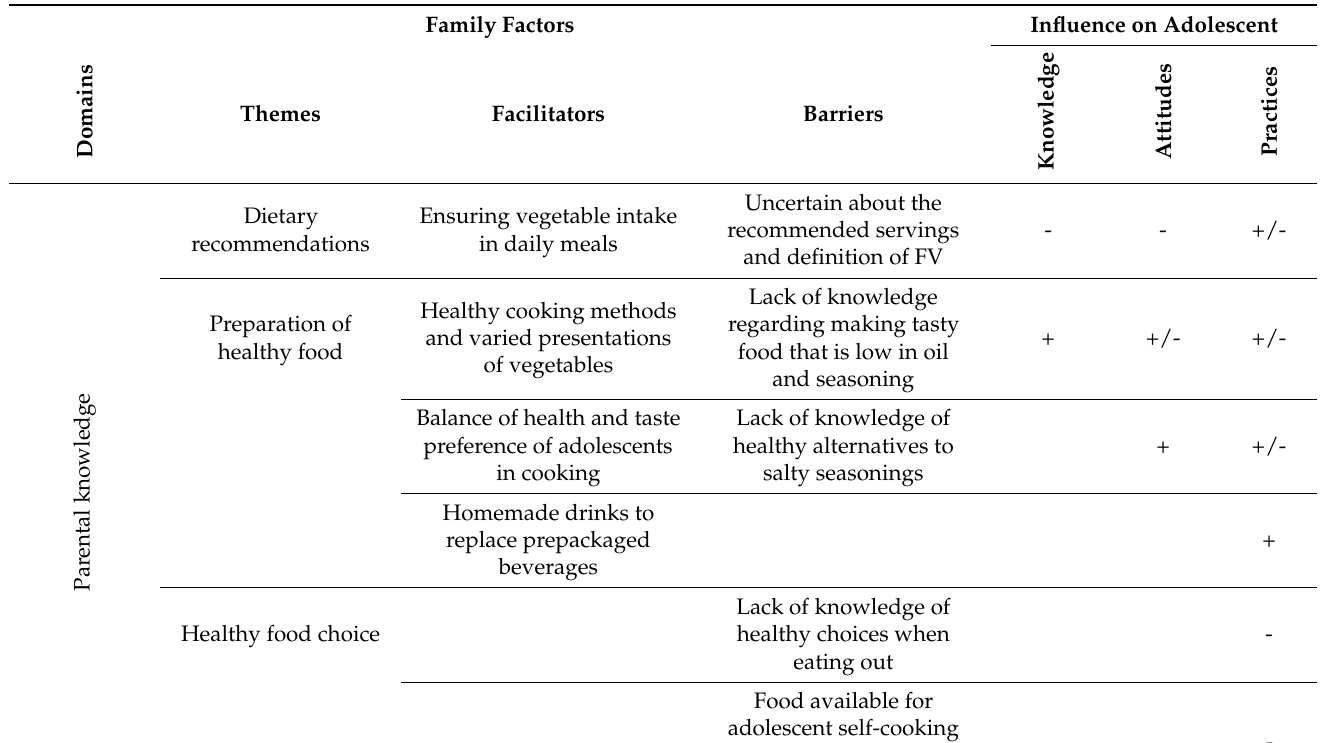
Table 3. Cont. Family